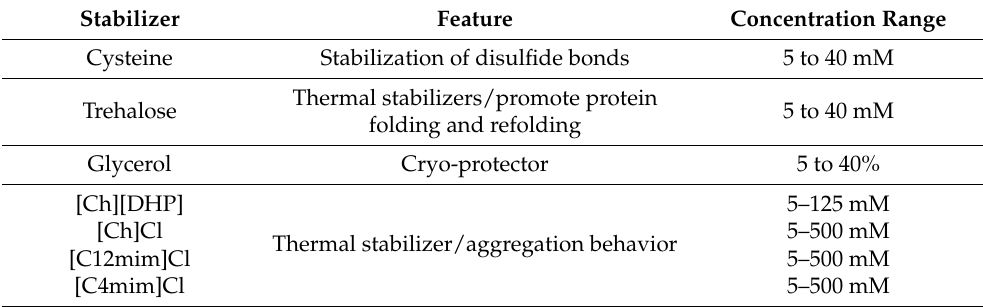
Table 6. hMBCOMT stabilizers features and